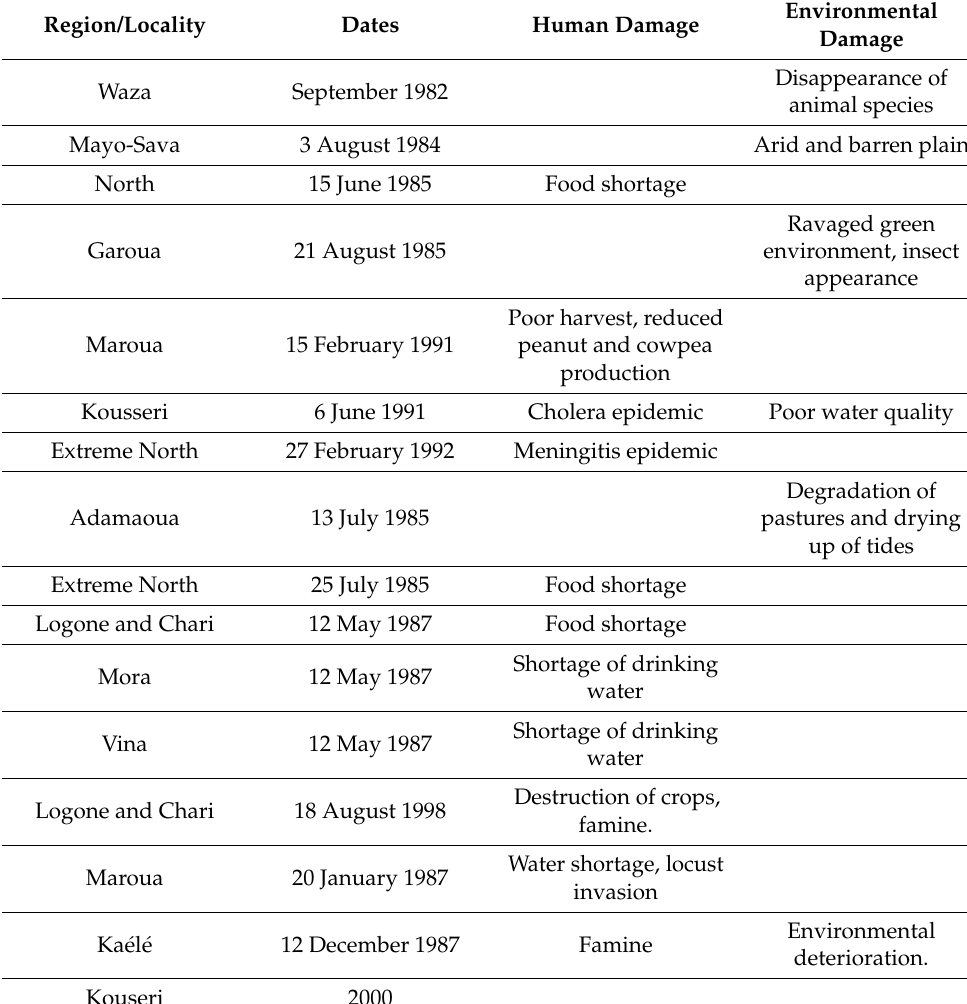
Table 2. Impact of drought on people and the environment in North Cameroon.